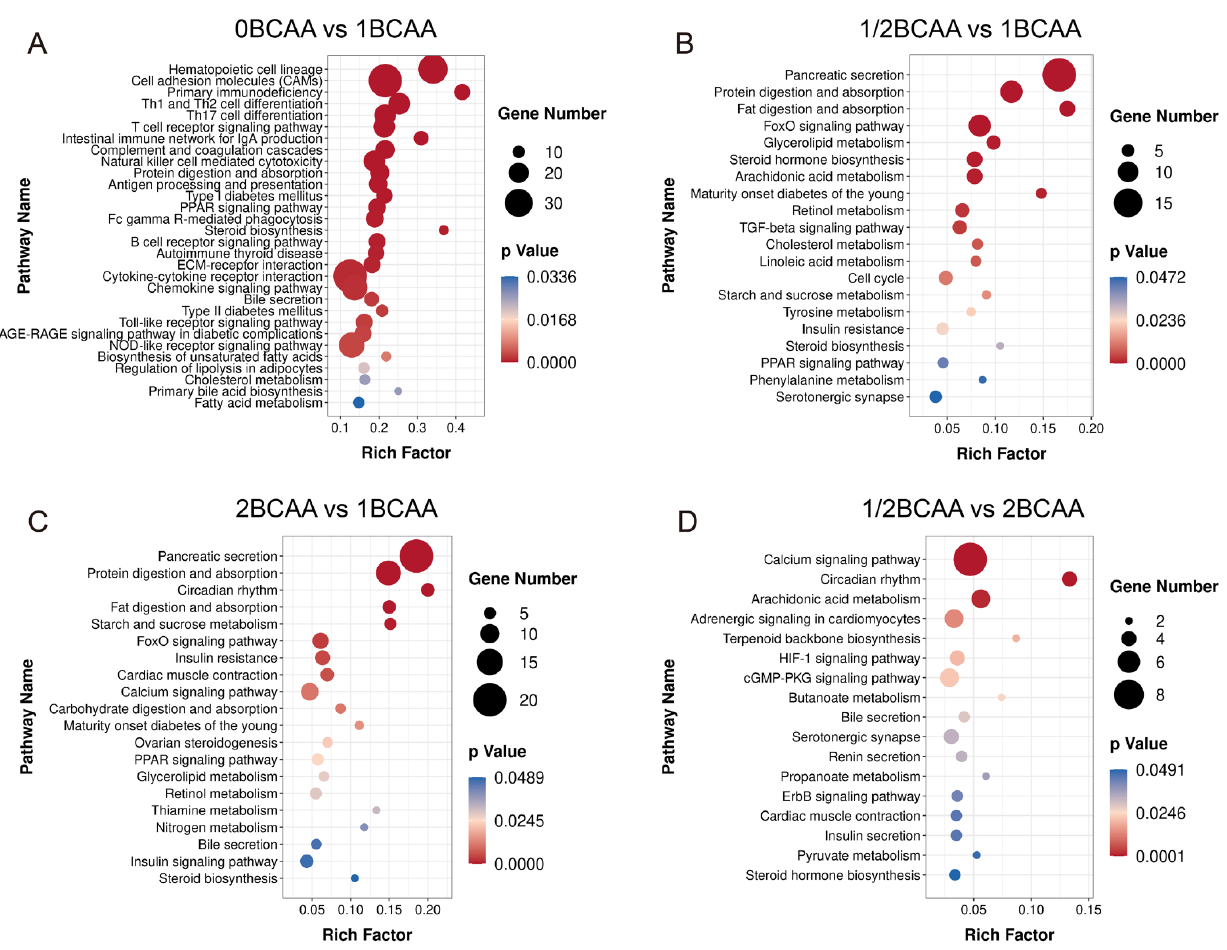
Figure 5. KEGG enrichment analysis of differentially expressed genes in four groups. ( A ): 0BCAA vs. 1BCAA; ( B ): 1/2BCAA vs. 1BCAA; ( C ): 2BCAA vs. 1BCAA; ( D ): 1/2BCAA vs. 2BCAA; KEGG: Kyoto encyclopedia of genes pathway.